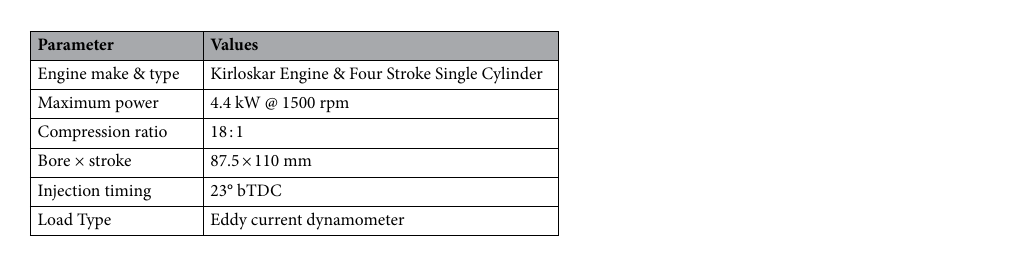
Table 4. Experimental test engine